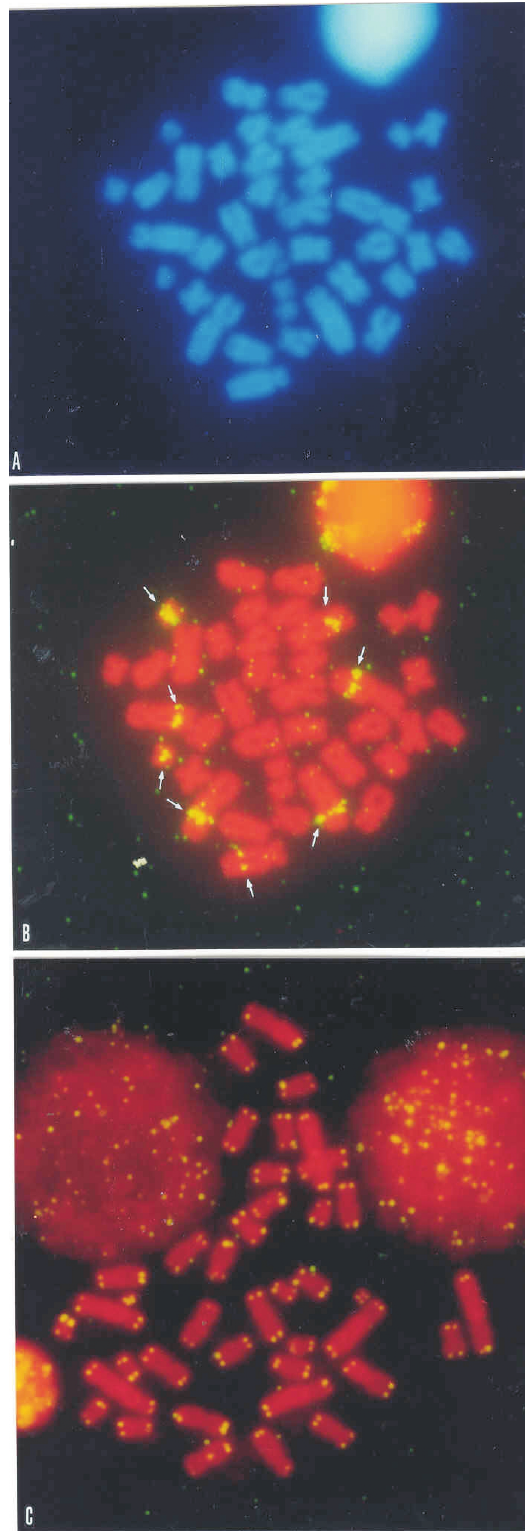
Figure 3 - ( In situ hybridization) FISH in S. a. ingrami (2n = 40): a) DAPI staining; b) same metaphase using ribosomal gene probes, showing eight signals at secondary constrictions on pairs 1, 2, 3, and 17; c) another metaphase using telomere probes, showing terminal signals on all chro-